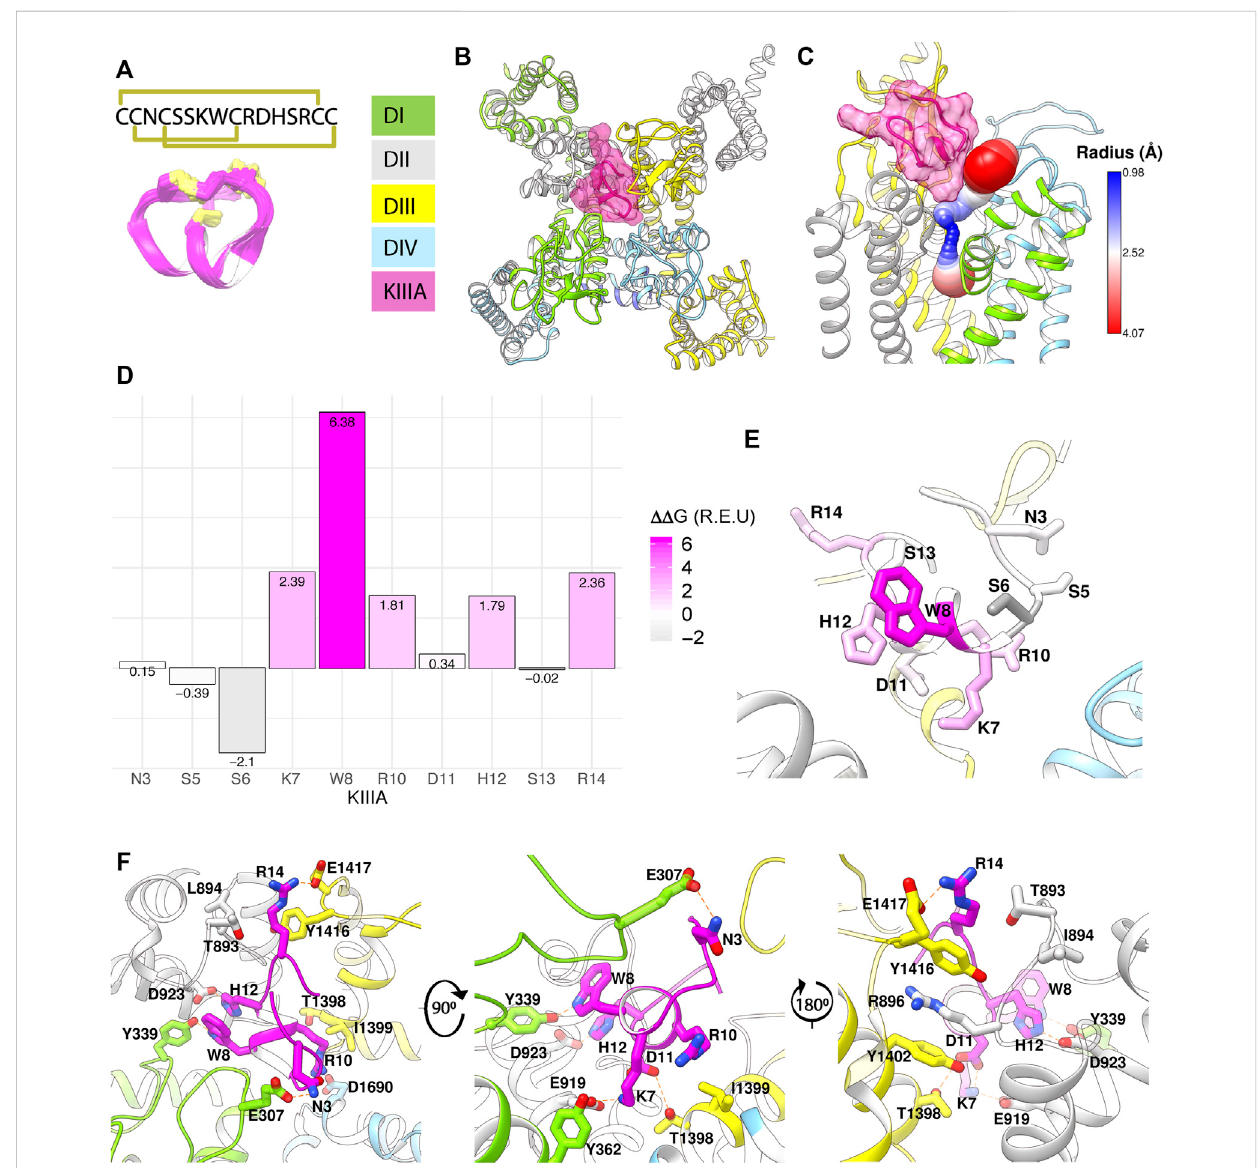
FIGURE 1 Structural modelofKIIIA — hNa V 1.7featureseccentricbindingoftoxintotheouterpore. (A) StructureandsequenceofKIIIA(PDB:2LXG)(Khooetal., 2012)show an alpha helical corestabilized by three disul fi de bridges. (B) Extracellular view of our KIIIA – hNaV1.7 complex homology model based on the EeNa V 1.4- β 1 cryo-EM structure (Yan et al., 2017). Channel domains are depicted according to color keys, and KIIIA is shown in magenta ribbon and surface.KIIIAbindseccentricallytotheouterporebetweenDIIandDIII. (C) AsideviewofchannelporerevealsanincompleteblockofKIIIAwithKIIIA bound (magenta) and cavity volume. (D) Rosetta alanine scan identi fi ed residues K7, W8, R10, H12, and R14 as signi fi cant contributors to binding energy. (E) Heatmap of Rosetta ΔΔ G on KIIIA structure shows the importance of the helical region for binding. (F) Close-up views of key interactions at KIIIA – hNa V 1.7